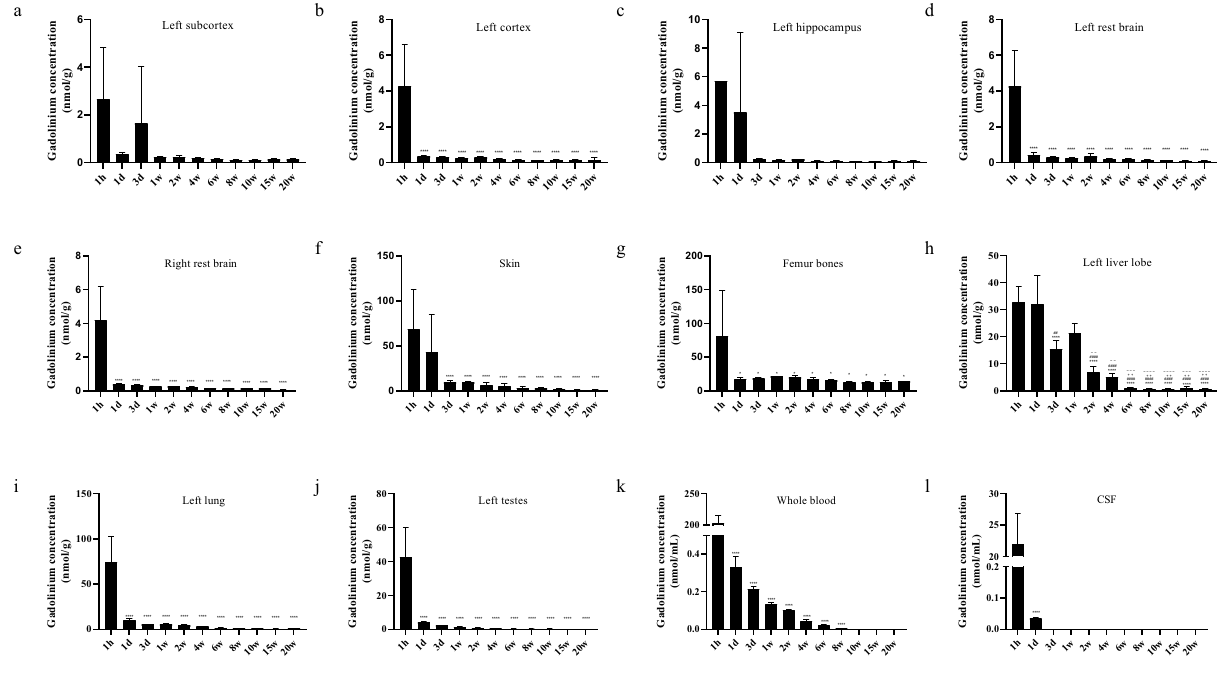
Figure 4. Gadolinium concentrations in tissues after a single gadodiamide administration. Gadolinium concentrations in whole cerebellum ( a ) Left subcortex, ( b ) left cortex, ( c ) left hippocampus, ( d ) left rest brain, ( e ) right restbrain, ( f ) skin, ( g ) femur bones, ( h ) left liver lobe, ( i ) left lung, ( j ) left testes, ( k ) whole blood and ( l ) CSF after rats were administered 0.6 mmol/kg gadodiamide. Measured gadolinium was BLOQ after 10 weeks in the whole blood and 3 days in the CSF. Graphs show mean ± SD (n = 3 per time point). Statistical analyses using a one-way ANOVA with a Dunnet’s post-hoc test, p ≤ 0.05*, < 0.01** /##/++/~~ , < 0.001***/ ~~~, < 0.0001****/ ~~~~ . The significance level of each comparison is indicated for each column when compared to 1 h (*), 1 day (#), 3 days (+) or 1 week (~) time points.